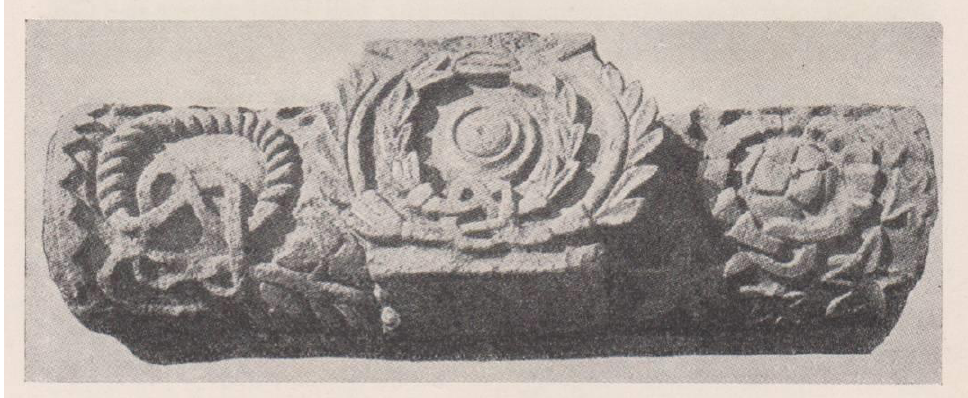
Figure 20. Frieze from the synagogue in Chorazin. Reproduced from Ernst Cohn-Wiener (1929, p. 88).